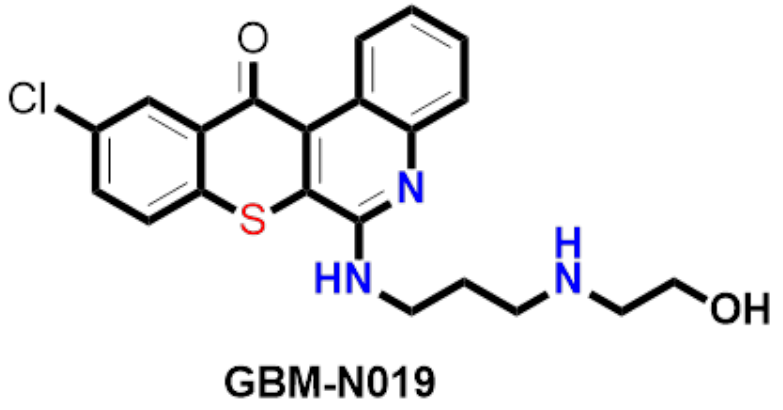
Figure 1. Chemical structure of